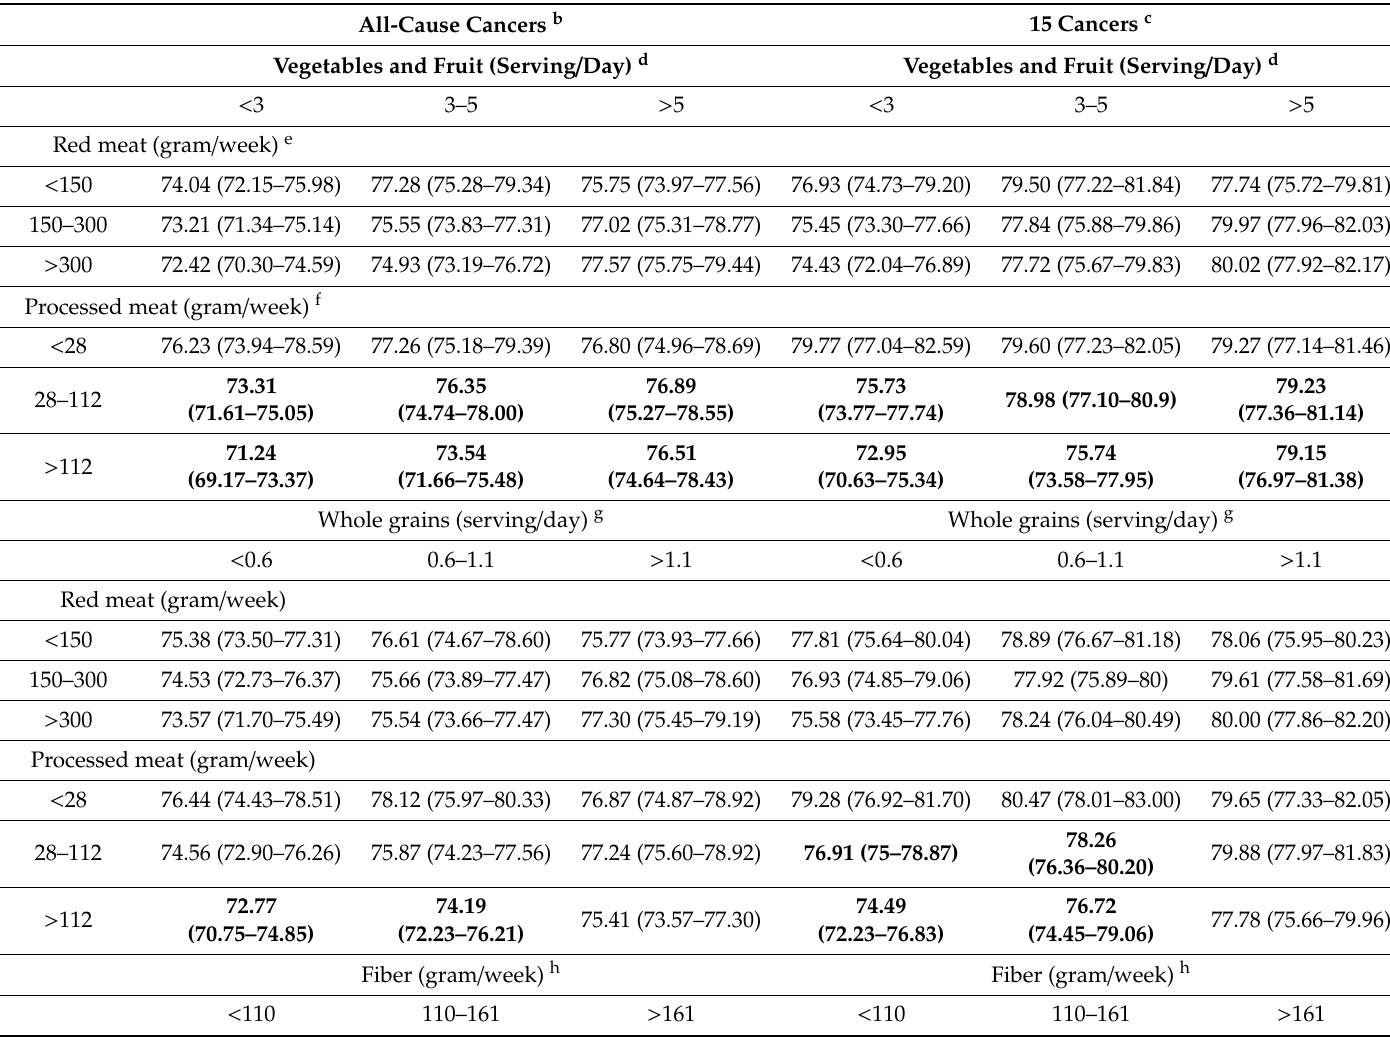
Table 5. Estimated median ages a and 95% confidence intervals for all-cause and 15 cancer incidence for di ff erent combinations of intake levels of red and processed meat with vegetables and fruit, whole grains, and fiber among women, Alberta’s Tomorrow Project ( n =